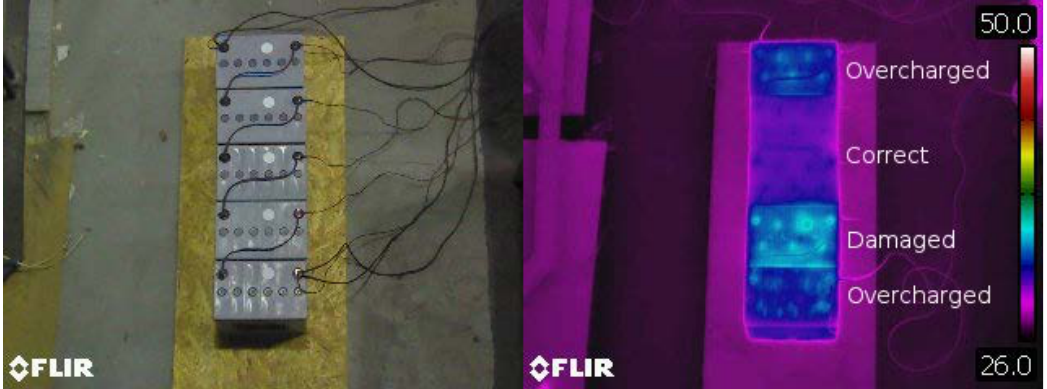
Figure 2. Thermogram of damaged and undamaged